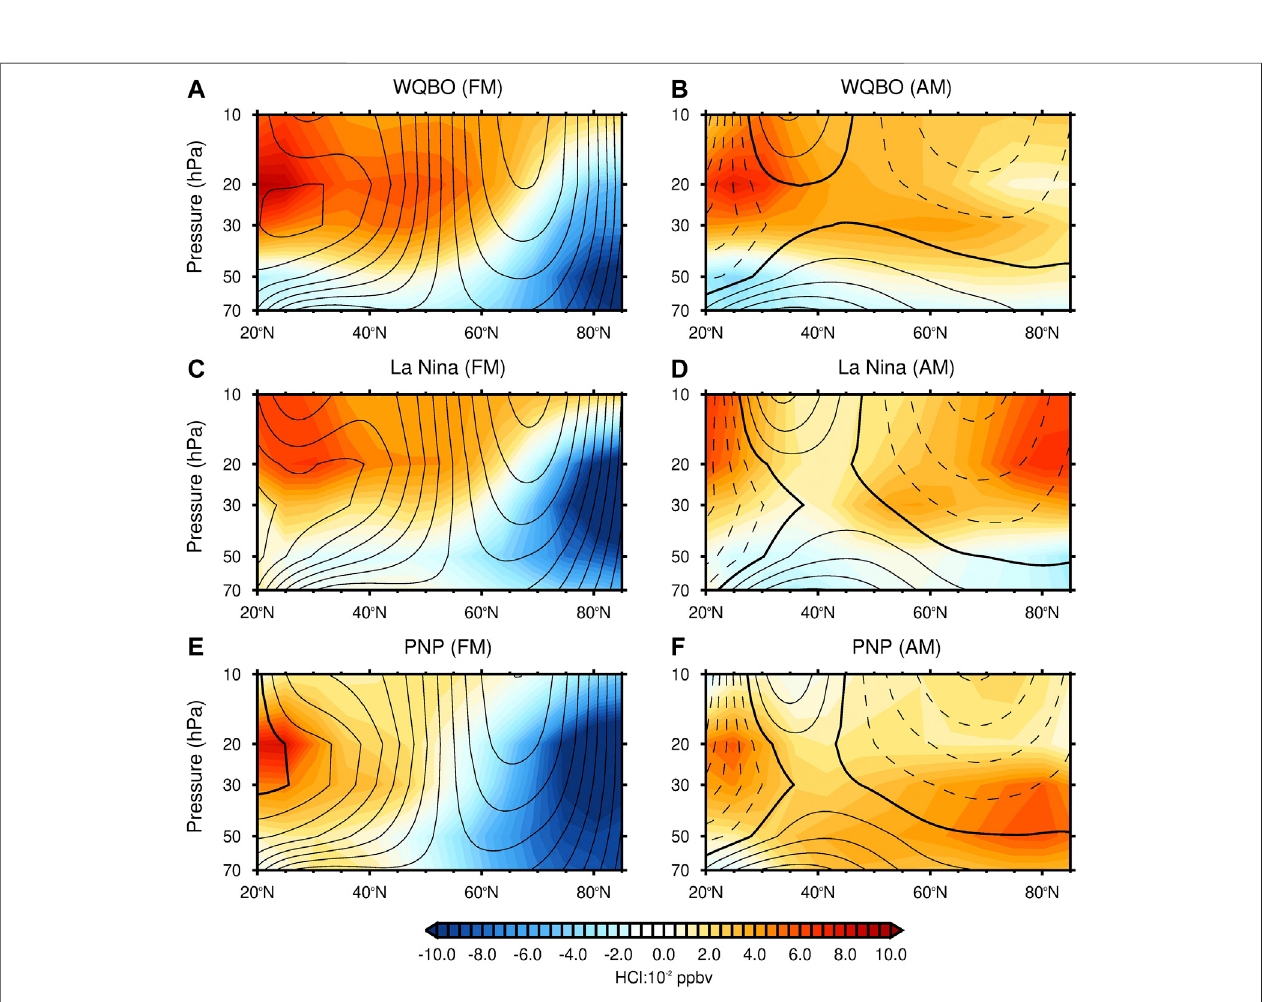
FIGURE 7 | Composite of (A,C,E) February – March (FM) and (B,D,F) April – May (AM) averaged Northern Hemisphere stratospheric HCl anomaly (color shading) and zonal-meanzonalwind (U,contours, interval is2 m s − 1 )for (A,B) WQBO phases, (C,D) LaNiña,and (E,F) positiveSSTanomaliesintheNorth Paci fi c(PNP), based on SLIMCAT model simulations (HCl) and ERA-Interim data (U) from 1979 to 2016. The events selected for composite analysis are listed in Table 2 . The HCl anomalies are obtained by removing the seasonal cycle. Thin solid lines represent positive U, dotted lines are negative U, and the thick solid line represents the zero line.